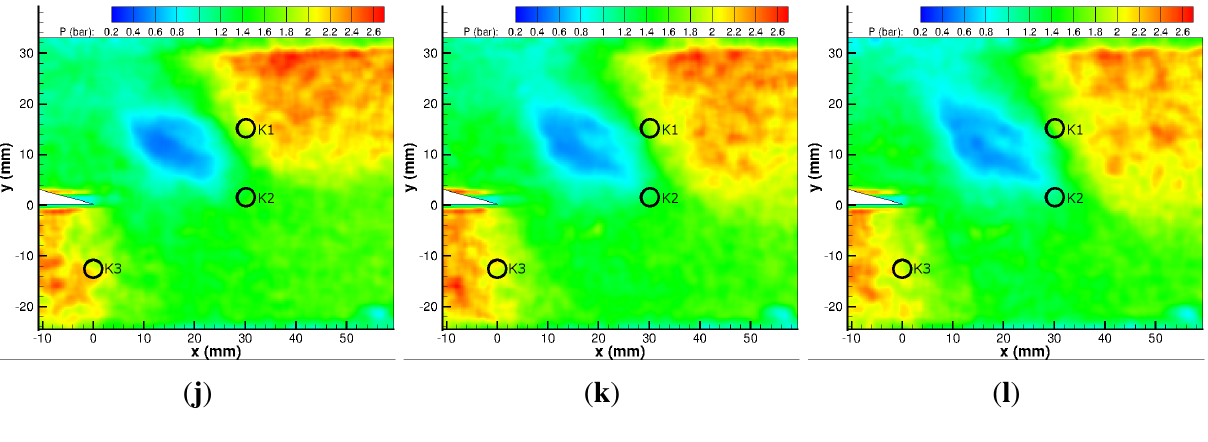
Figure 14. Experimental and numerical pressure map showing the lambda